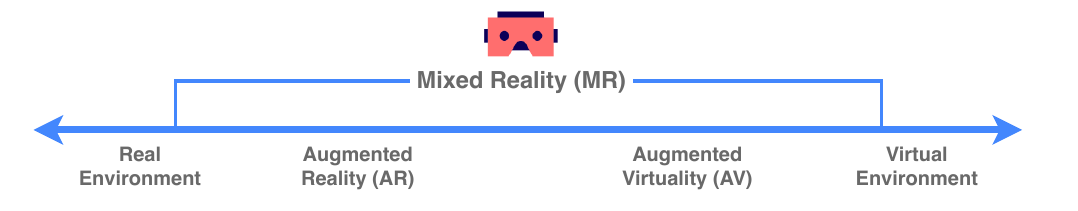
Figure 1. Reality-virtuality